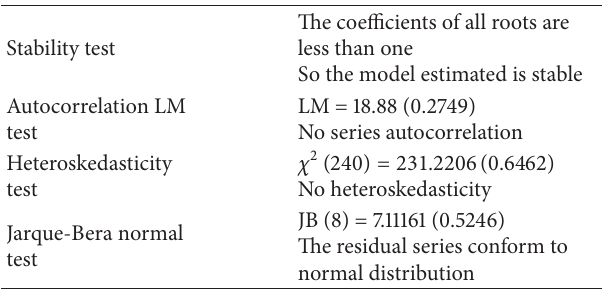
Table 4: The model test